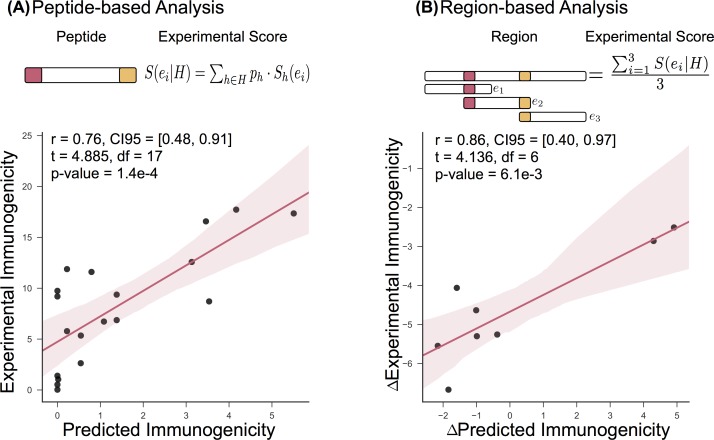
(A) Correlation of experimental and predicted immunogenicity of each peptide. The experimental immunogenicity score of a peptide is defined as the linear combination of the individual experimentally determined relative HLA binding affinity of each HLA allele h ∈ H weighted by the HLA allele frequency. (B) Correlation of experimental and predicted immunogenicity of the whole redesigned region. The summarized immunogenicity score of the whole region is the linear combination of the overlapping peptides used to reconstruct the region, normalized by total number of peptides used. The predicted immunogenicity scores per peptide were computed according to our immunogenicity objective function. The red lines are a fitted linear regression and the red tubes represent their 95-confidence interval.